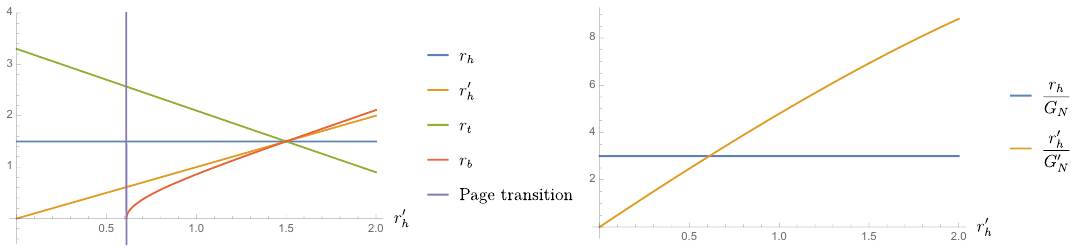
Figure 7 . Left: horizon radii, the brane location r t and the scale r b as a function of r 0 protocol described in the main text. We have r b < r 0 the neighborhood of the Page transition. Right: the Bekenstein-Hawking entropies associated to the causal horizons during the same protocol. The orange curve is not a straight line because G 0 slightly changes during the